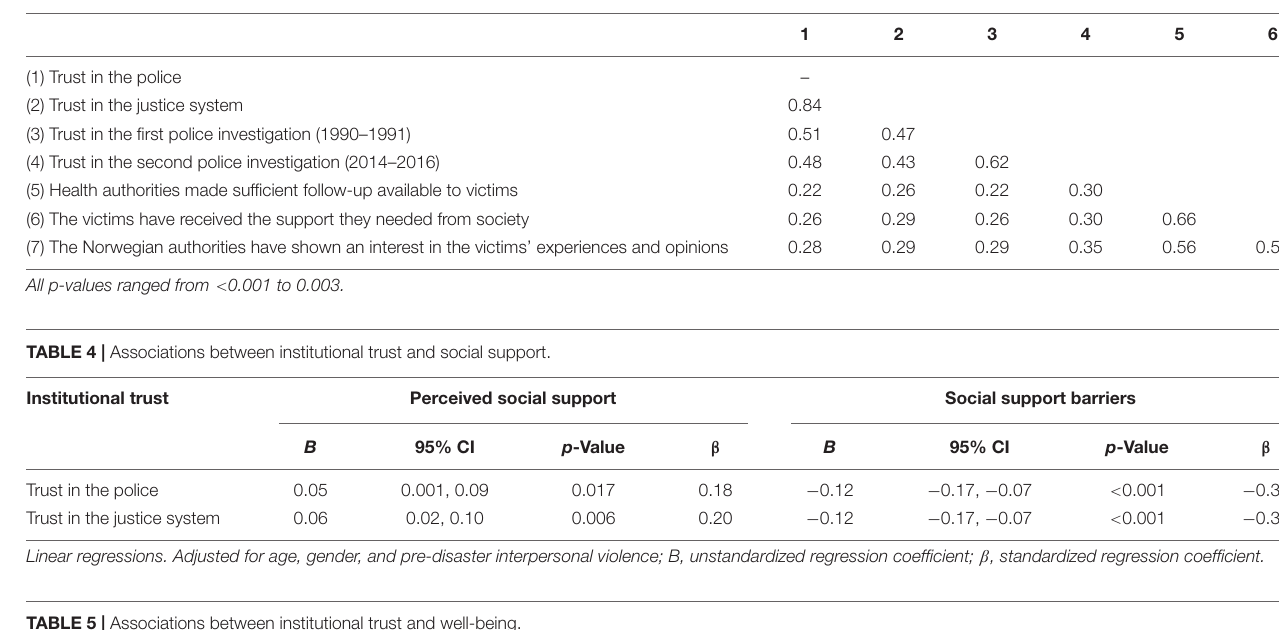
TABLE 5 | Associations between institutional trust and well-being. Institutional